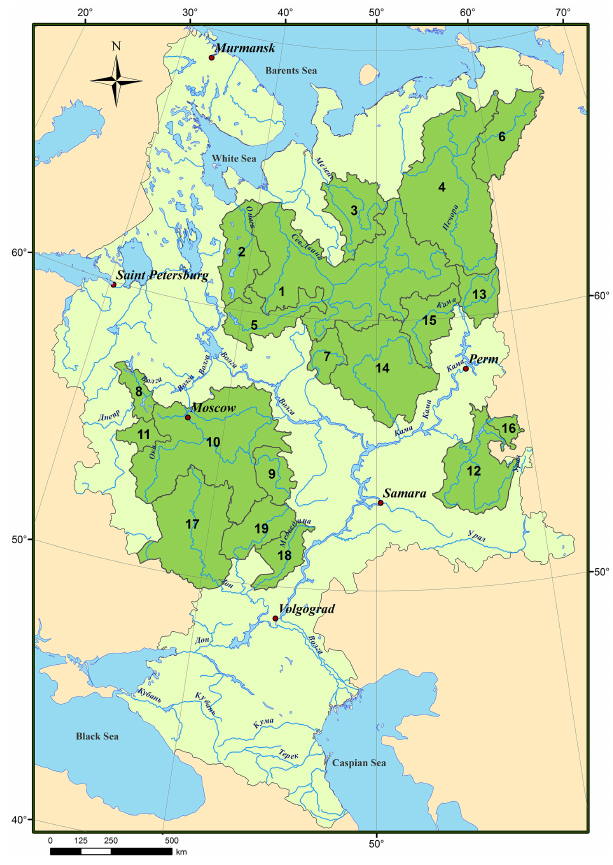
Figure 3. The map of representative basins (the numbers of the basins corresponds to Table 1).